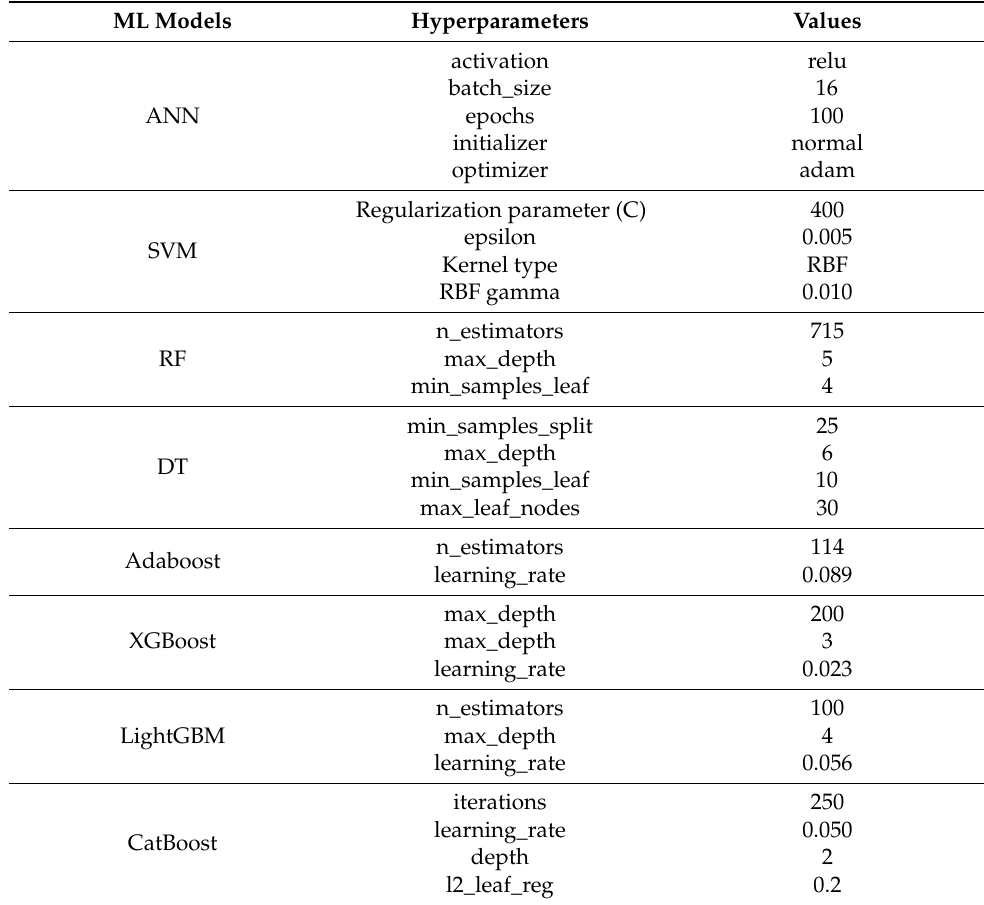
Table 2. Initial ML models and their hyperparameter